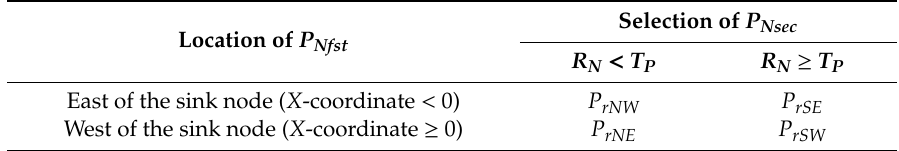
Table 4. Selection of a second level phantom node ( P Nsec ) according to the first level phantom node ( P Nfst ) location and value of the random number ( R N